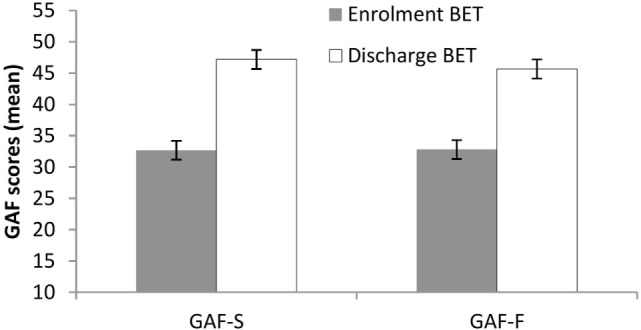
Changes in Global Assessment of Functioning from enrollment to discharge. Lines are SEs.